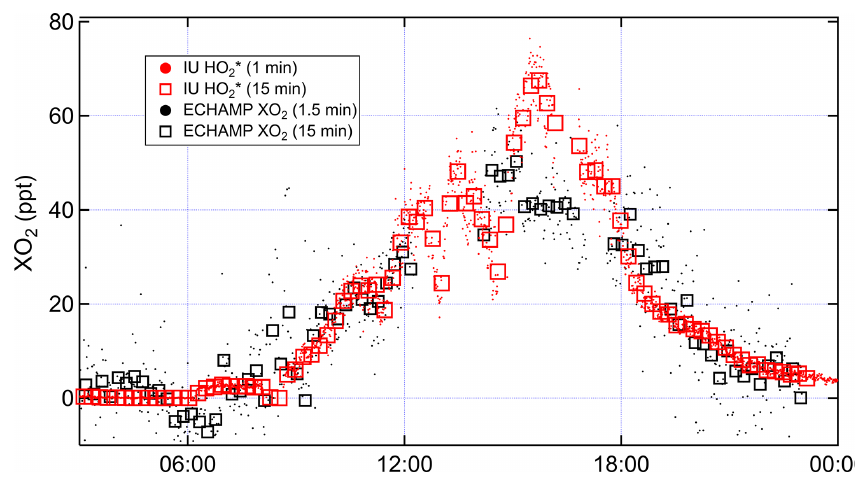
Figure 7. Time series comparing IU LIF-FAGE HO ∗ run in HO ∗ -only 2